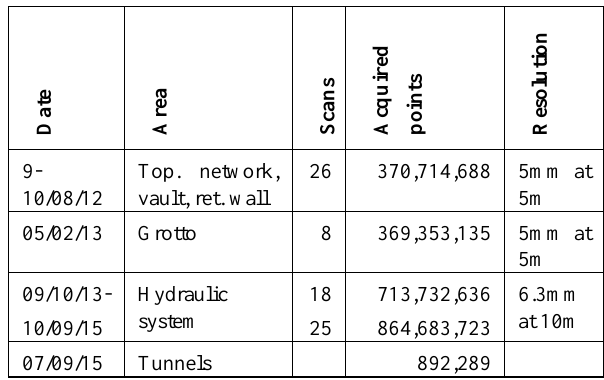
Table 2. Summary of data acquired at different stages